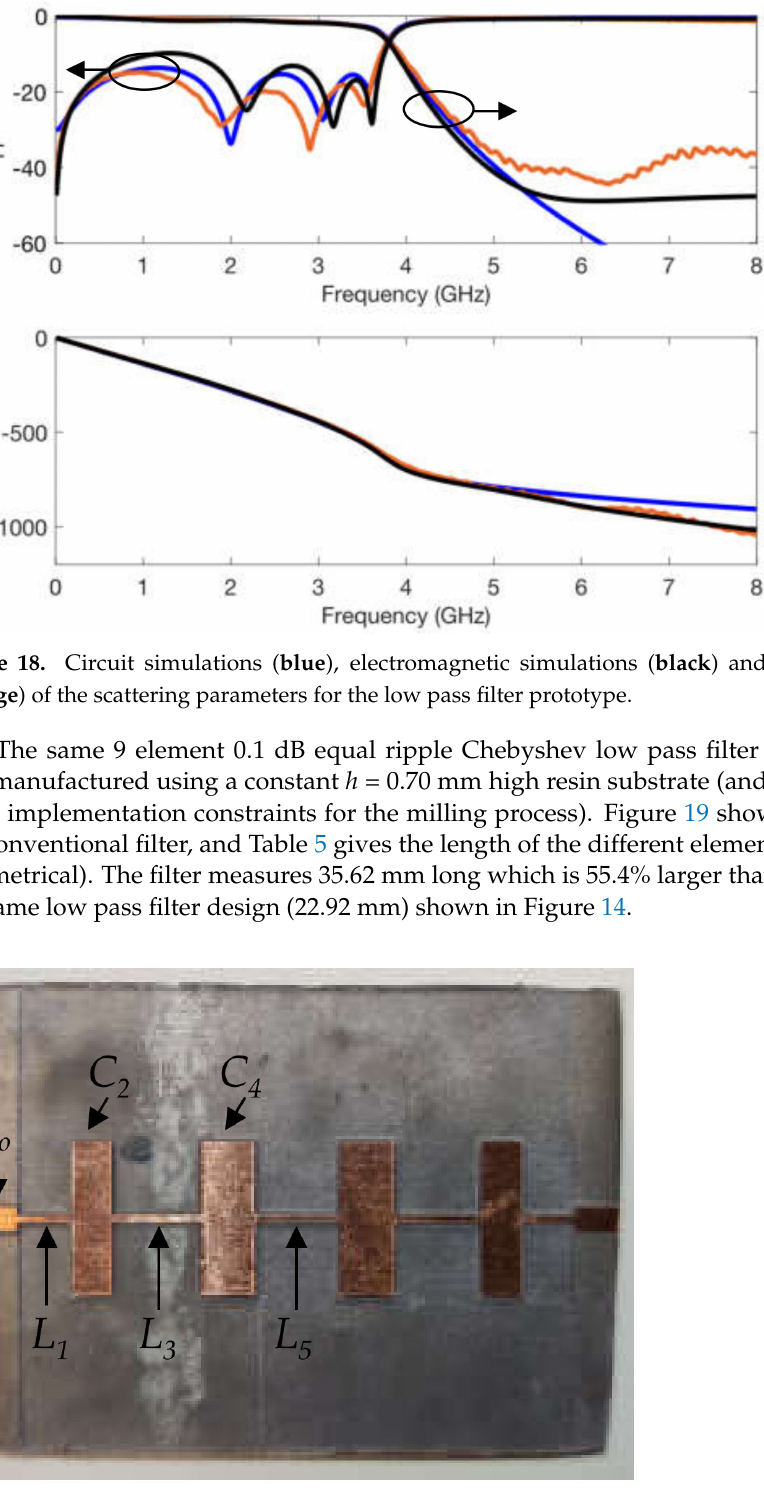
Figure 19. Final implementation of the low pass filter prototype using a resin printed constant h = 0.7 mm high